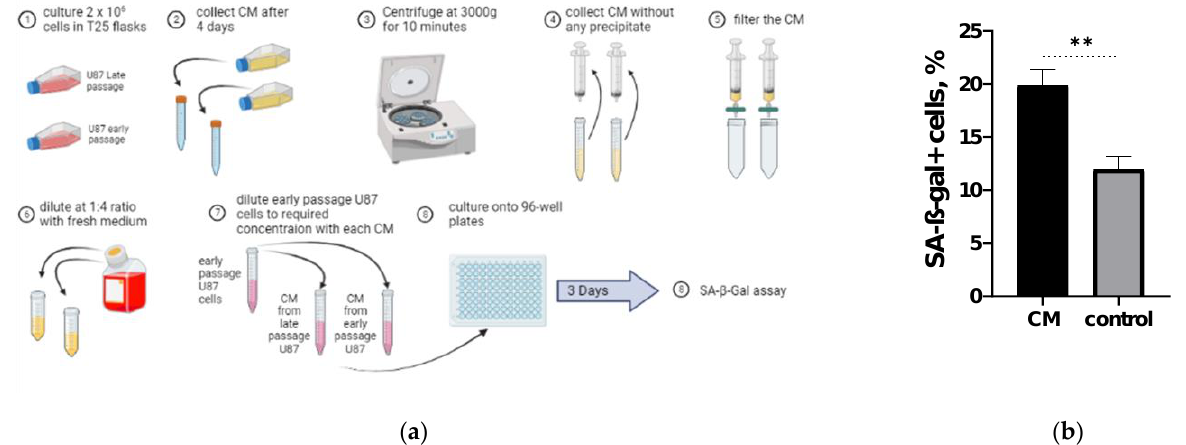
Figure 5. Assessment of the formation of SA- β -Gal positive cells in U87L line cultured in conditioned medium (CM) obtained from U87H cells. Schematic representation of the experiment ( a ). Percentage of SA-b-Gal positive cells formed in U87L cells cultured in CM and in the medium from U87L cell line (control) ( b ). ** p < 0.01.